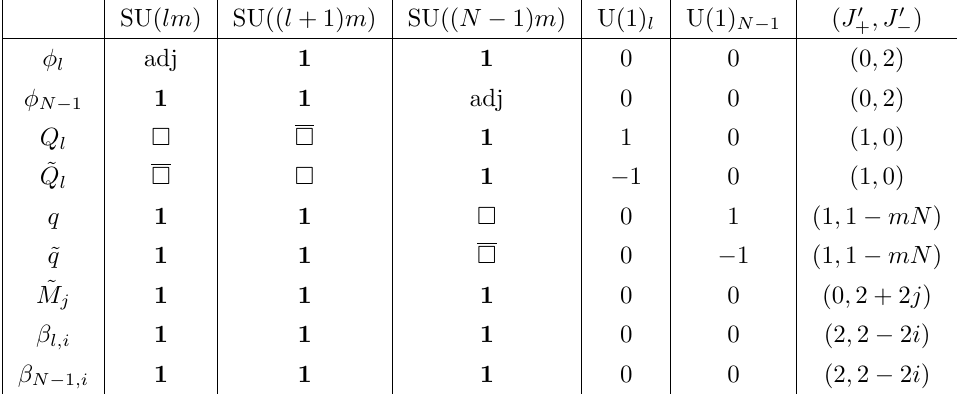
) theories. ( k = mN ) − 1